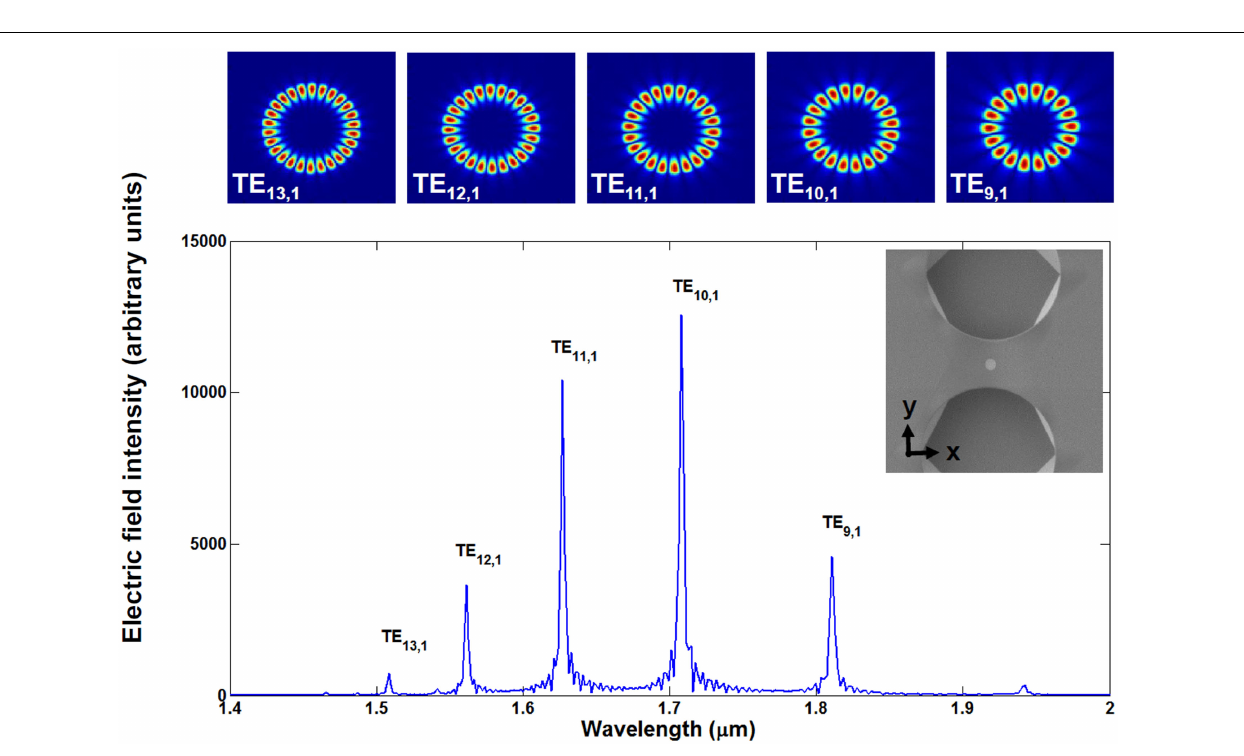
FIGURE 6 | Spectrum of electric field ( ⃗ε x ; y ) resonances in-plane of a 3 µ m disk on a suspended SiO 2 beam (shown in the SEM image inset) . Confined modes with sharp peaks are whispering gallery modes as confirmed by the surface plots (top) of the vertical magnetic field component ( ⃗ H z